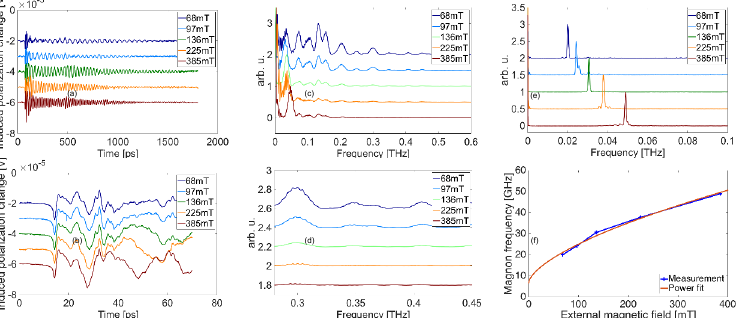
Fig. 2. Oscillations measured after excitation by a strong THz pulse in FeBO 3 (a,b) with Fourier transform (c-e), when varying the external continuous magnetic field (THz field strength: 0.35 T). The scans were performed with 1.8 ns range and 1 ps resolution (slow oscillations) or 70 ps with 2 fs resolution (fast oscillations). (a) slow oscillations following the fast ones (b) after the THz excitation. (c) Fourier transform of the fast oscillations, zoomed on 0.28 - 0.45 THz in (d). (e) Fourier transform of the slow oscillations. (f) Evolution of magnon frequency with the continuous magnetic